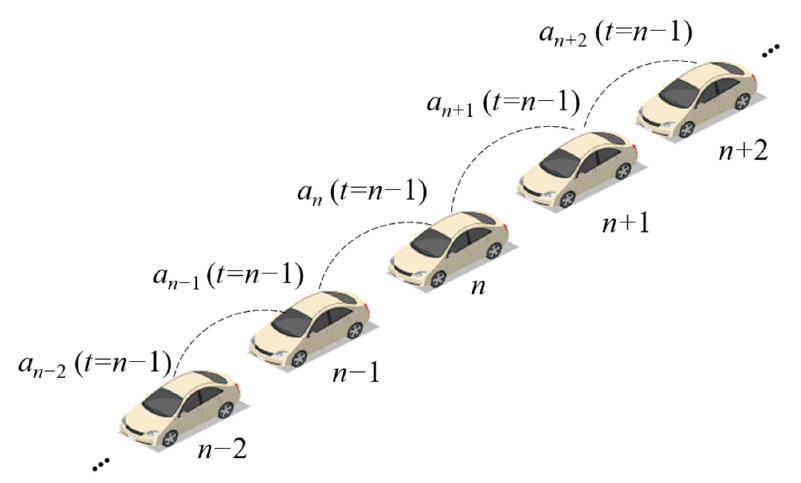
Figure 1. The information exchange between vehicles of the BDVIS.